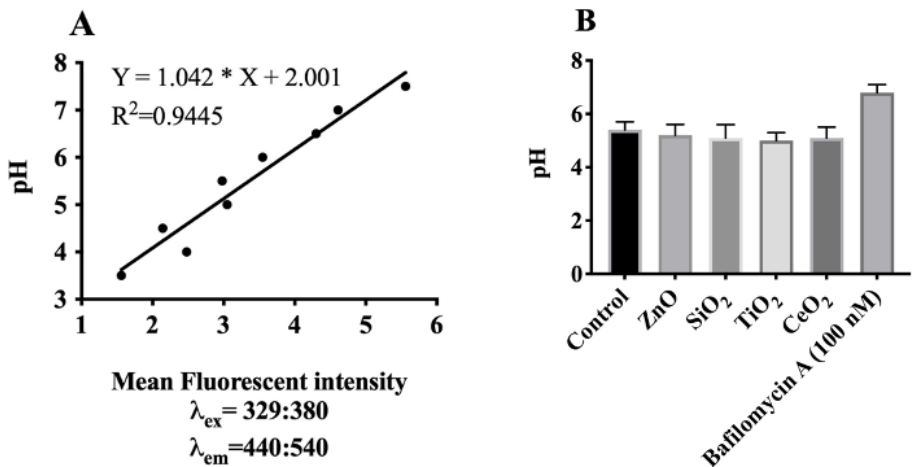
Figure 6. Estimation of intralysosomal pH in AM using ratiometric dye LysoSensor Yellow/Blue DND-160. ( A ) Calibration curve was generated using a SpectraMax M4 spectrofluorometer as described in the Methods. Emission spectra were collected at 440 and 540 nm for excitations at 329 and 380 nm, respectively. ( B ) Fluorescence intensity ratios of individual NP- or SiO 2 -treated cells were converted to pH-values by fitting of the data to the corresponding pH calibration curve. Data are presented as means ± SEM of triplicate measurements. Data were analyzed by two-way ANOVA according to Holm–Sidak’s multiple comparion test.